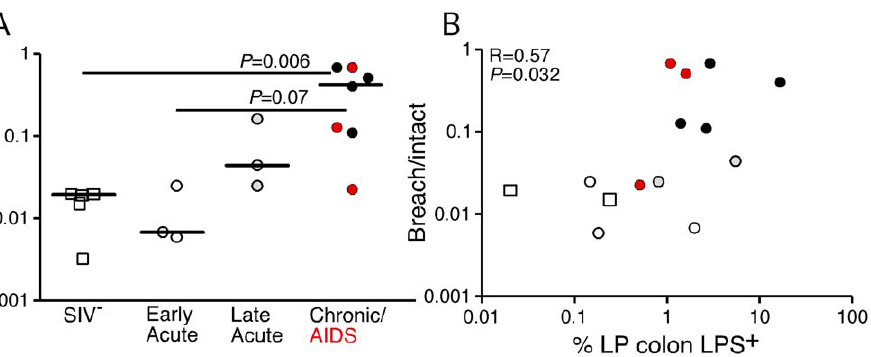
Figure 8. Damage to the integrity of the epithelial barrier correlates with microbial translocation. ( A ) Quantitative image analysis showing the proportion of the epithelial lining in the large bowel that is damaged (discontinuous) in SIV-uninfected (white squares), early acute (white circles), late acute (gray circles), chronic Non-AIDS (black circles) and chronic AIDS (red circles) RMs. Mann-Whitney U test performed between the chronically infected (both Non-AIDS and AIDS) and early acute RMs and between chronically infected (both Non-AIDS and AIDS) and SIV- RMs. ( B ) Statistically significant positive correlation between the proportion of epithelial damage and the level of LPS within the LP of the colon. Significance determined using Spearman’s rank correlation coefficient and associated P-value shown.